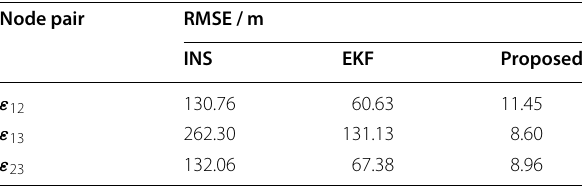
Table 4 Comparison of RMSE index of three relative positioning algorithms Node pair